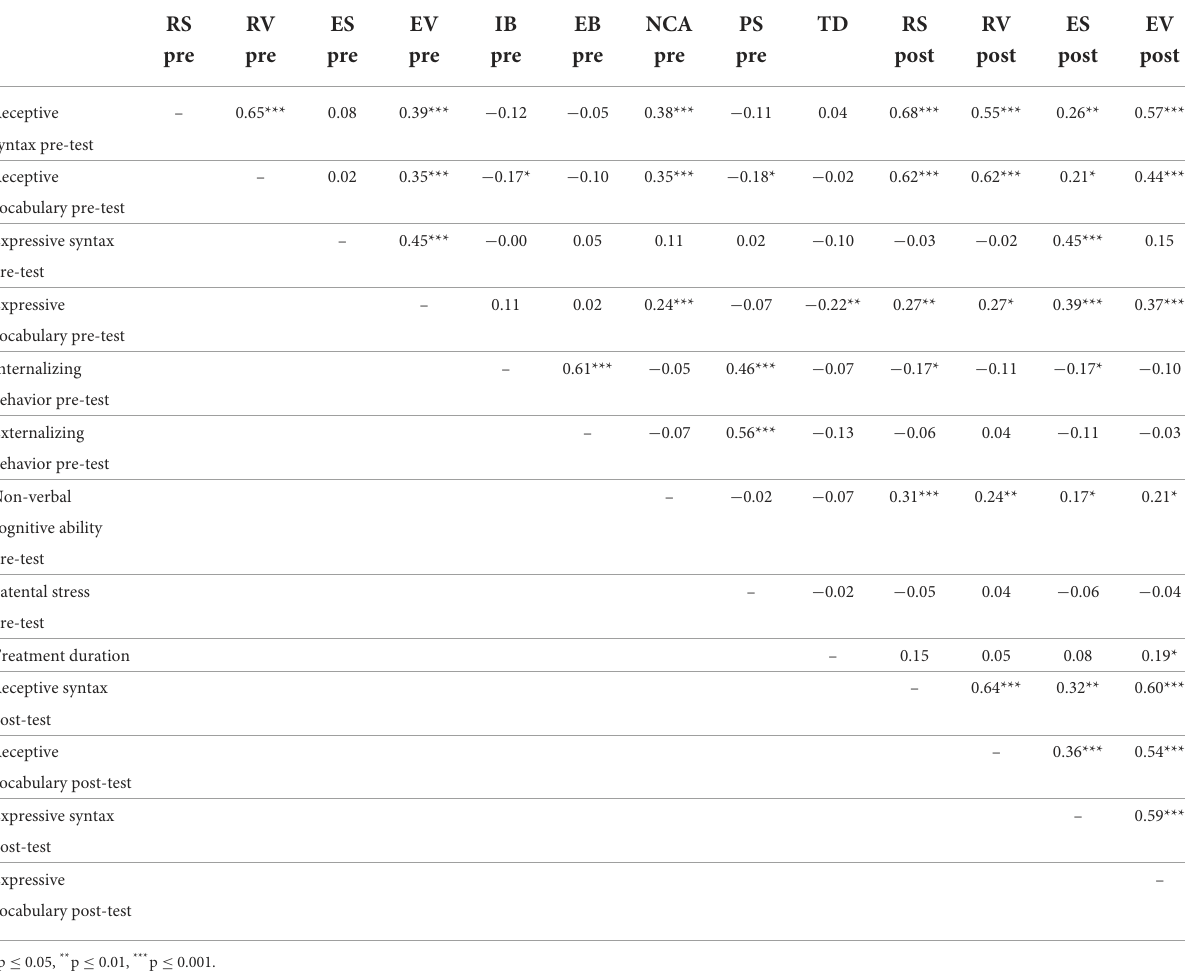
TABLE 3 Correlations between the pre-test language scores, predictors and post-test language